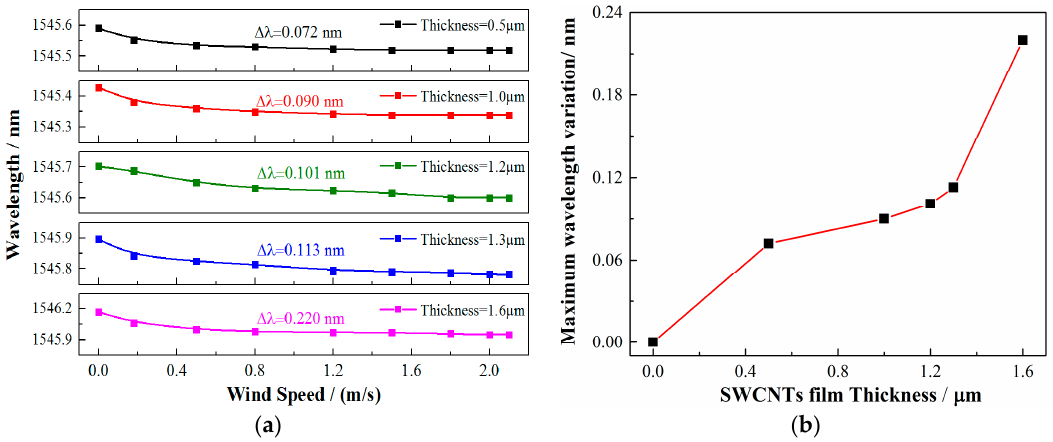
Figure 8. ( a , b ) Wavelengths responses of the 12° TFBGs with different film thicknesses under the same input power of 22.97 mW.